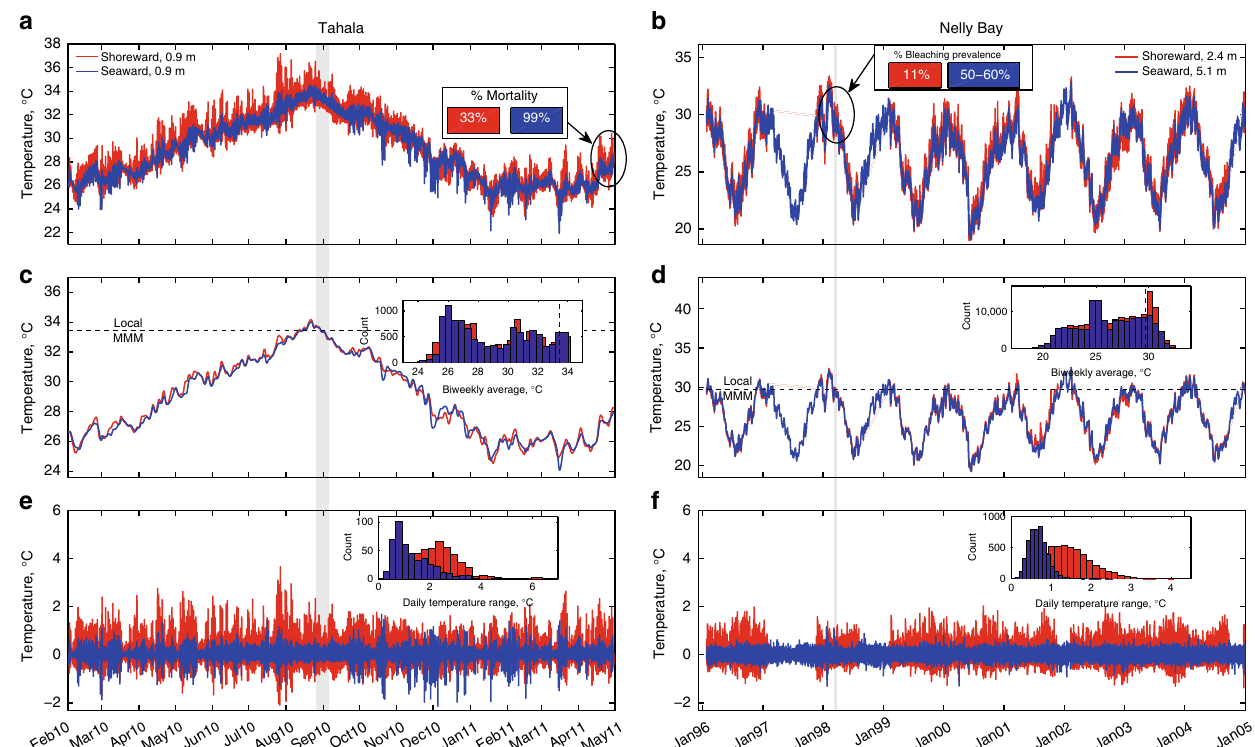
Fig. 6 Same-reef case studies. a Temperature time series taken from the wave-exposed (blue) and wave-protected (red) edges of the Tahala reef platform in the Red Sea, which are separated by ~200 m. The percentage of observed mortality, which was associated with the bleaching event in September 2010 46,84 , is indicated for each corresponding platform edge. c 2-week low-pass fi ltered time series of the raw Tahala temperature data, with the Maximum Monthly Mean (MMM) temperature calculated using the in situ data for each time series. e 33-h high-pass fi ltered time series of the raw Tahala temperature data, with a histogram of the Daily Temperature Range (DTR) values for each time series. b , d , f Analogous versions of a , c , and e , respectively, but for the Nelly Bay reef fl at (red) and reef slope (blue) habitats in the Great Barrier Reef, separated by ~122 m. Bleaching prevalence as proportions of belt transects 56 are also indicated in b . The gray bars highlight the approximate periods of reported bleaching equal to 10 years in duration were divided into 3-year sections, while all others were divided into 4-month sections. Sections were overlapped by 50% and wind- owed with a Hamming function before spectra for each section were calculated, which were then ensemble averaged to obtain the PSD estimate. The statistical signi fi cance ( α = 0.05) of observed spectral peaks was ascertained by comparison with the upper con fi dence level of a background red noise fi t to the spectrum 67 . We empirically de fi ned annual, seasonal, and diurnal frequency bands as 0.00185 to 0.0111, 0.0119 to 0.143, and 0.727 to 1.333 cycles per day (cpd), respectively. Band variance was computed using trapezoidal integration of PSD values within each respective frequency range, and ratios of high-frequency to seasonal band variances among habitat types ( “ Back Reef ” , “ Reef Flat ” , “ Reef Slope ” ) were compared using a Kruskal − Wallis test (Supplementary Fig. 2b).